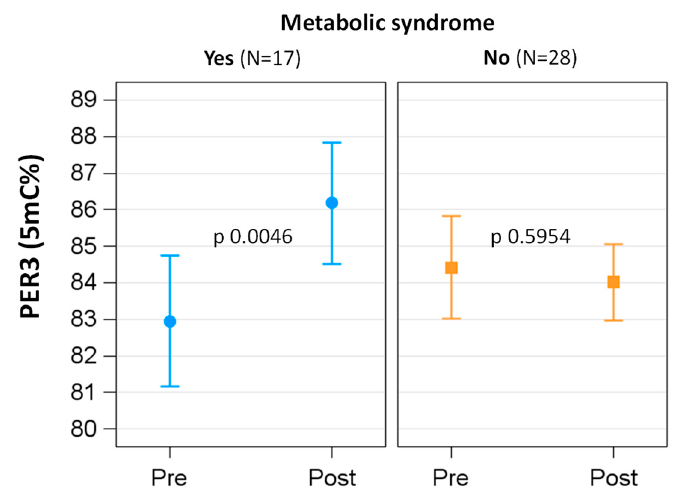
Figure 2. DNA methylation level of the per3 gene in subjects with or without metabolic syndrome: pre- vs. post-BWRP comparisons.